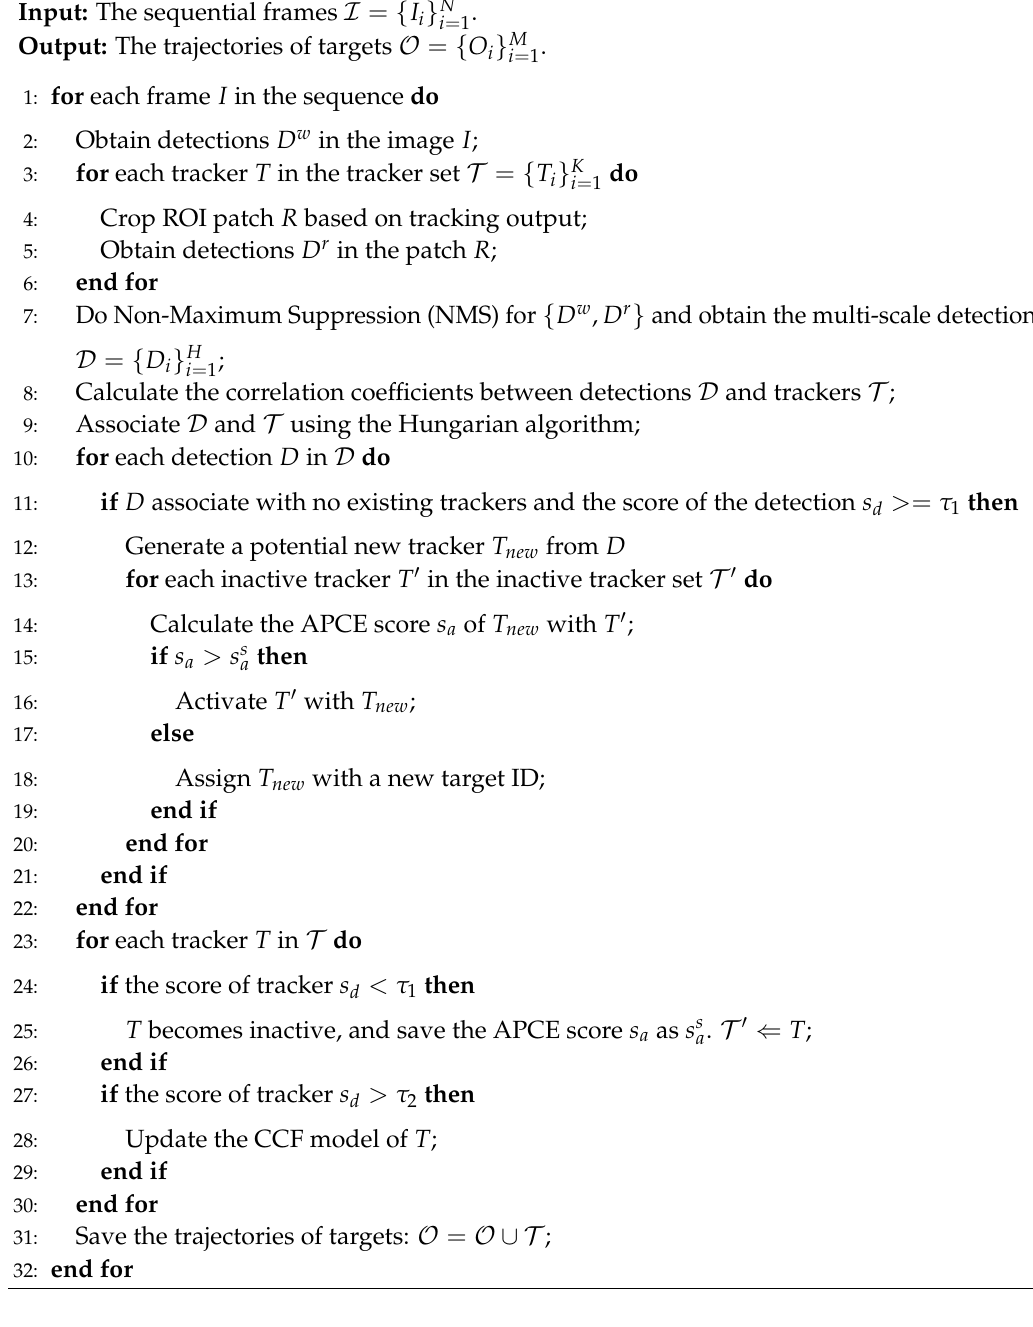
Algorithm 1 Multi-Object Tracking with Compressed CNN Feature Based Correlation